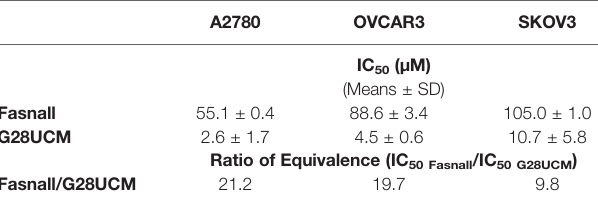
TABLE 1 | IC 50 values and their quotient (ratio of equivalence) as metrics for growth inhibition by FASN inhibitors Fasnall and G28UCM in A2780, OVCAR3, and SKOV3 OC cells as determined with a formazan dye